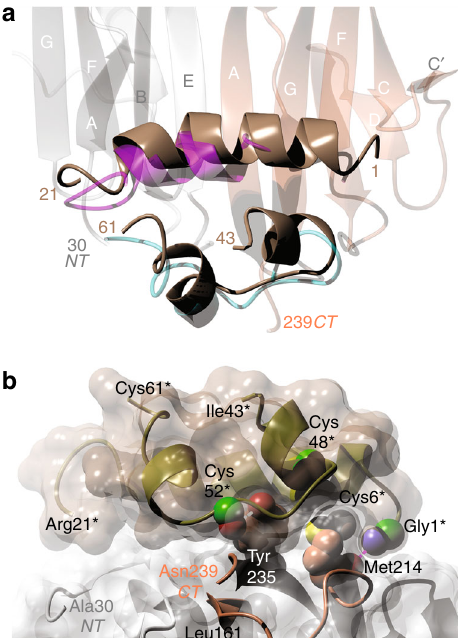
Fig. 5 Structure of the Imp-L2:IGF-1 complex. a Comparison of DILP5 and human IGF-1 Imp-L2 binding modes, within the hormone binding area of the Imp-L2. IGF-1 is in brown, and DILP5 in magenta (B-chain) and light blue (A-chain); NT and CT are the apo-Imp-L2 termini and colour coded as in Fig. 3. b A close-up on some IGF-1:Imp-L2 major binding interaction seen from the direction of the Imp-L2 N-terminal and C-terminal. IGF-1 B 1 – 21 helix has also a light brown Van der Waals surface, while its A-segment is in gold only. IGF-1 amino acids numbers marked with stars. Imp-L2 Van der Waals surface in white. IGF-1 N-termini capping hydrogen bond to Imp-L2 CO group of Met214 in dash magenta line, and IGF-1 Cys52 CO hydrogen bond to OH of Imp-L2 Tyr235 in a white dash